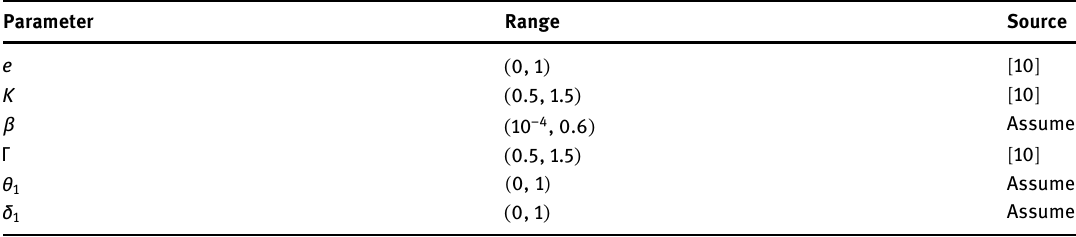
Table 1: Range of parameters used to study the in fl uence of parameters on rumors spread Parameter